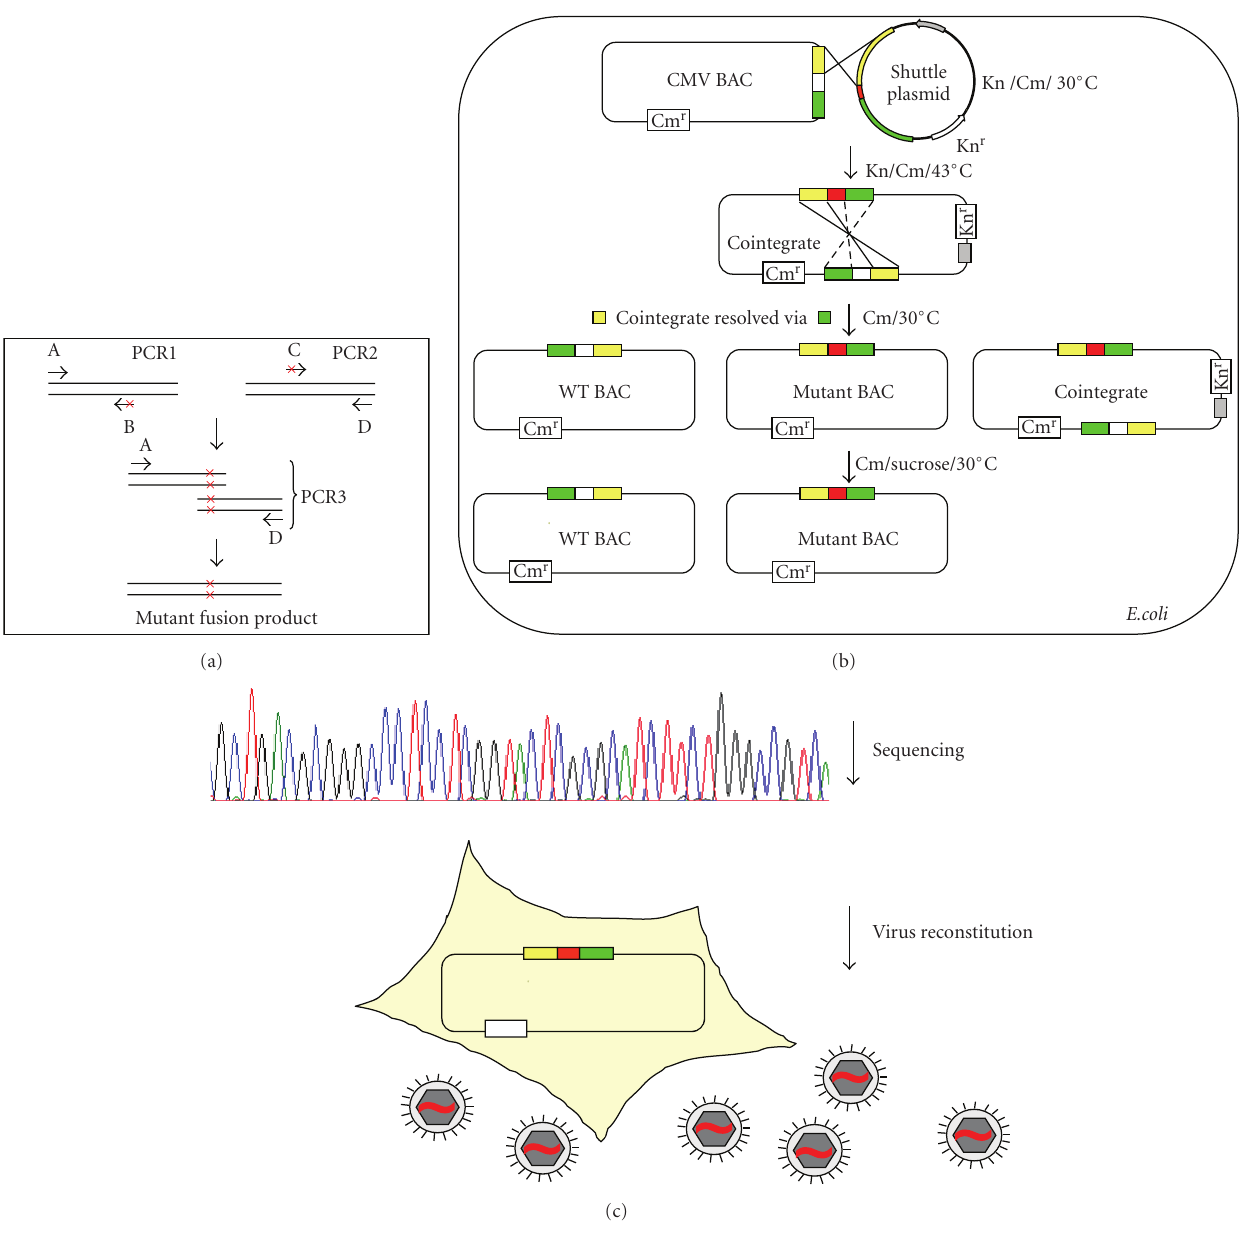
Figure 1: Method of herpesvirus point mutagenesis. (a) Site-directed mutagenesis by overlap extension. The dsDNA and primers are represented by double lines and arrows, respectively. The direction of the arrows is indicating the 5 (cid:4) -to-3 (cid:4) orientation of primers, which are denoted by capital letters. The site of mutagenesis is marked with red symbol X. PCR amplificates yielded by PCR1 and PCR 2 served as templates in the combination PCR (PCR3) performed with primers A and D to generate the final amplificate that includes the intended point mutation. (b) Shuttle-plasmid allelic exchange in Escherichia coli . A shuttle plasmid harbouring the point mutation (red box) flanked by homologous viral sequences (green and yellow boxes) is transformed into bacteria that contain the CMV BAC. The first homologous recombination leads to formationof cointegrates due to recombination via one homology arm. Cointegrates are selected by chloramphenicol (Cm) and kanamycin (Kn). Nonintegrated shuttle plasmids are removed at 43 ◦ C. In the second recombination step, cointegrates are resolved to generate either a WT viral BAC (via yellow box) or a mutant viral BAC (via green box). Clones still containing cointegrates are eliminated by sucrose counterselection against SacB (gray box), and finally, bacterial clones containing either mutated or WT CMV BACs are isolated (see [61, 62], for detailed description of the method, see [82]). (c) DNA of selected bacterial clones was tested for genomic structural integrity, and the presence of the mutation was confirmed by sequencing. Reconstitution of BAC-derived recombinant virus was achieved by transfection of mutated BAC DNA into permissive eukaryotic cells. After at least four viral passages and a second round of plaque purification, PCRs were performed to verify the absence of BAC vector sequences